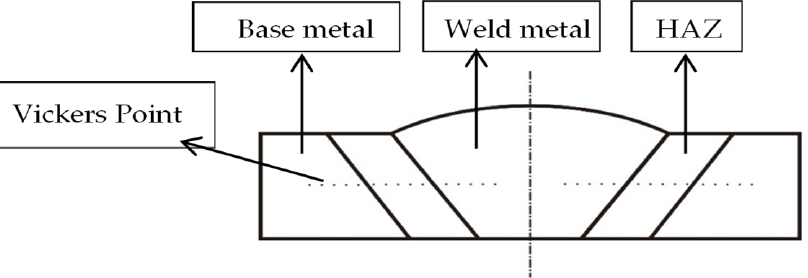
Figure 7. Cross-section of the welded specimen.